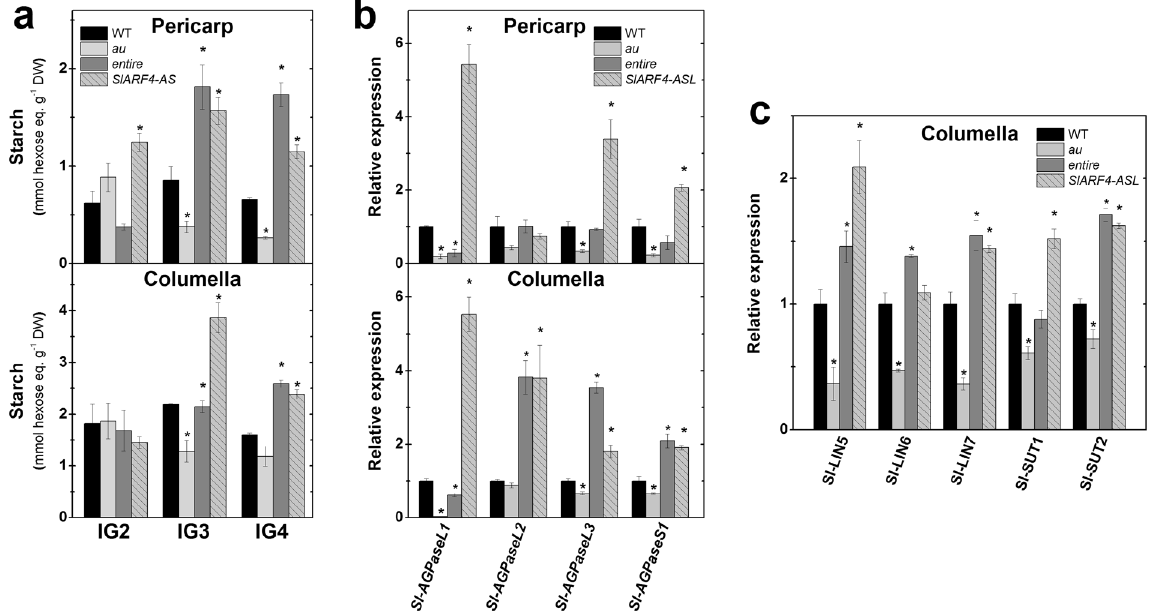
Figure 6. Auxin promotes starch accumulation by increasing transcript abundance of sink- and starch biosynthesis-related genes. Starch content and transcript levels of sink- and starch biosynthesis-related genes were monitored during the early development of aurea ( au ), entire and Sl-ARF4 -silenced line ( SlARF4-ASL ) fruits. (a) Starch content in pericarp and columella tissues of immature green (IG2 to IG4) fruits. (b) Transcript abundance of tomato genes encoding ADP-glucose pyrophosphorylase ( AGPase ) in pericarp and columella tissues of immature green 2 (IG2) fruits. (c) Transcript abundance of tomato genes encoding invertases ( Sl-LIN ) and sucrose transporters ( Sl-SUT ) in columella tissues of IG2 fruits. Values shown are mean ± SE. Transcript abundance was normalized against WT at each fruit developmental stage. Asterisks indicate statistically significant differences (Student’s t-test, P < 0.05) compared with the WT. IG2 to IG4, immature green stages (corresponding to early fruit development).